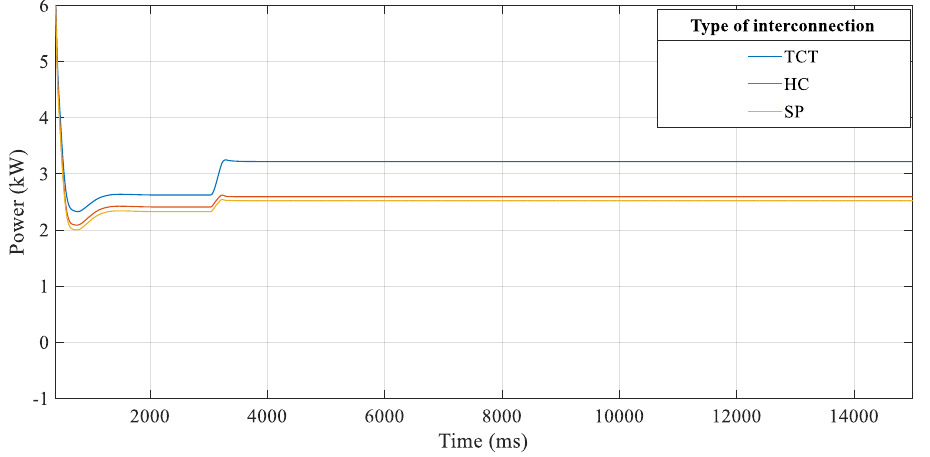
Figure 24. Impact of non-uniform shading fault ‘F3′ on power grid (thin-film PV).